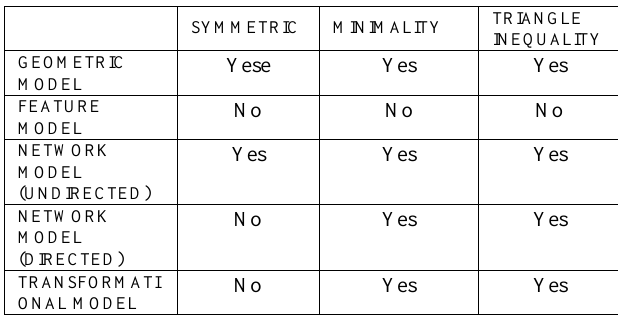
Figure 1. Concepts are mapped into a two-dimensional space: one dimension is “Tree Species” and the other is “Dominated Area”. The dimension of Tree Species is a nominal dimension with the range of {Deciduous Tree, Evergreen Tree}, while the dimension of Dominated Area is a ratio dimension with the range of [0, 100%]. The range of the super-concept covers its sub-concepts in this situation, which can be demonstrated from a comparison of dashed areas in Figure 1.